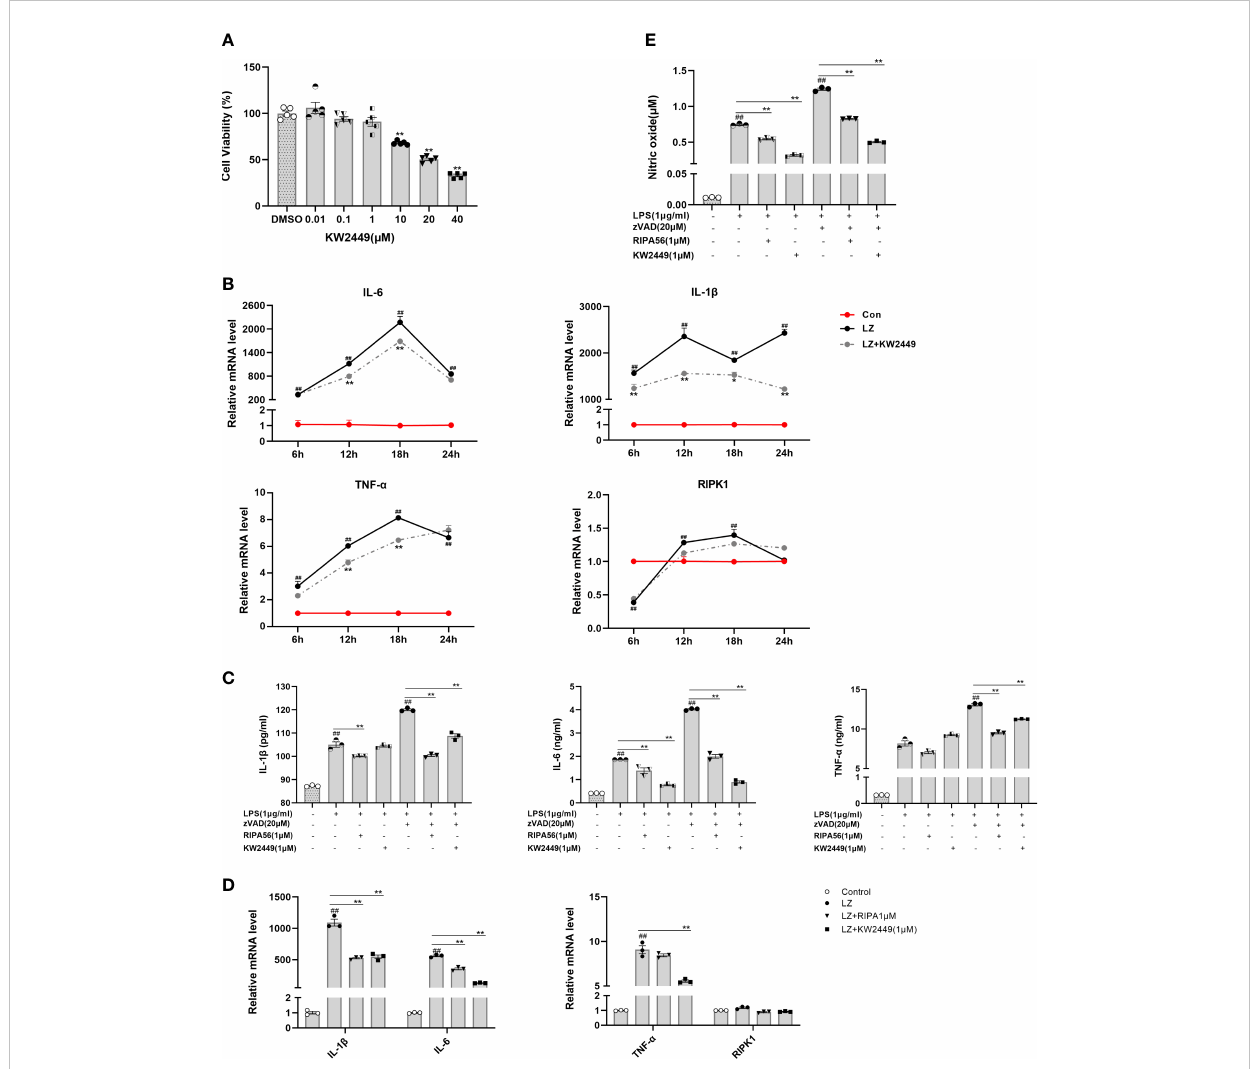
FIGURE 3 KW2449 reduced in fl ammation in LZ-induced necroptosis. (A) Cell viability in RAW 264.7 cells was determined at different concentrations of KW2449 by CCK-8 assay. Means ± SEs, n=5, * P < 0.05, ** P < 0.01, vs. DMSO. (B) The effects of KW2449 on IL-6, IL-1 b , TNF- a and RIPK1 at